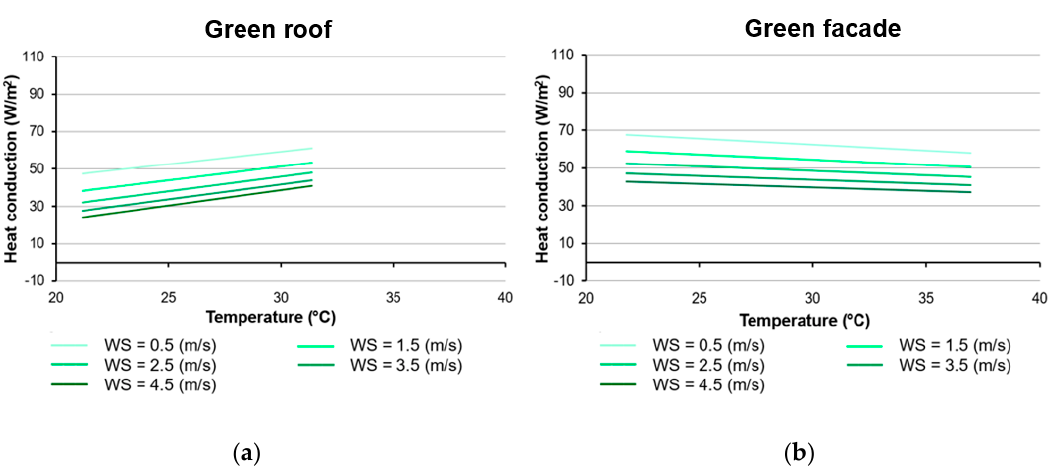
Figure 12. Sensitivity of ( a ) the heat conduction through the green roof and ( b ) the heat reduction through the green façade to wind velocity for solar radiation of 800 W/m 2 and relative humidity of 50%.